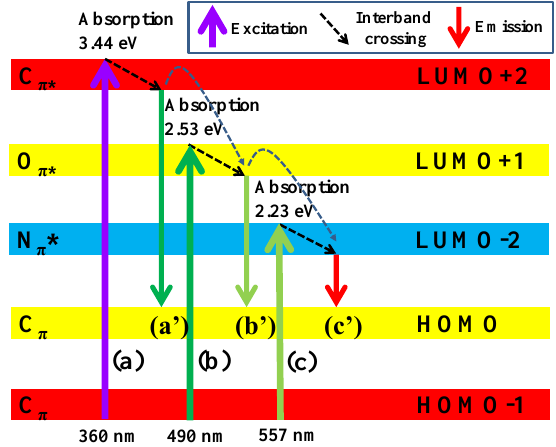
Figure 5. Inter-band gap structure model of PEG 6000 /CDs under different light illuminations.